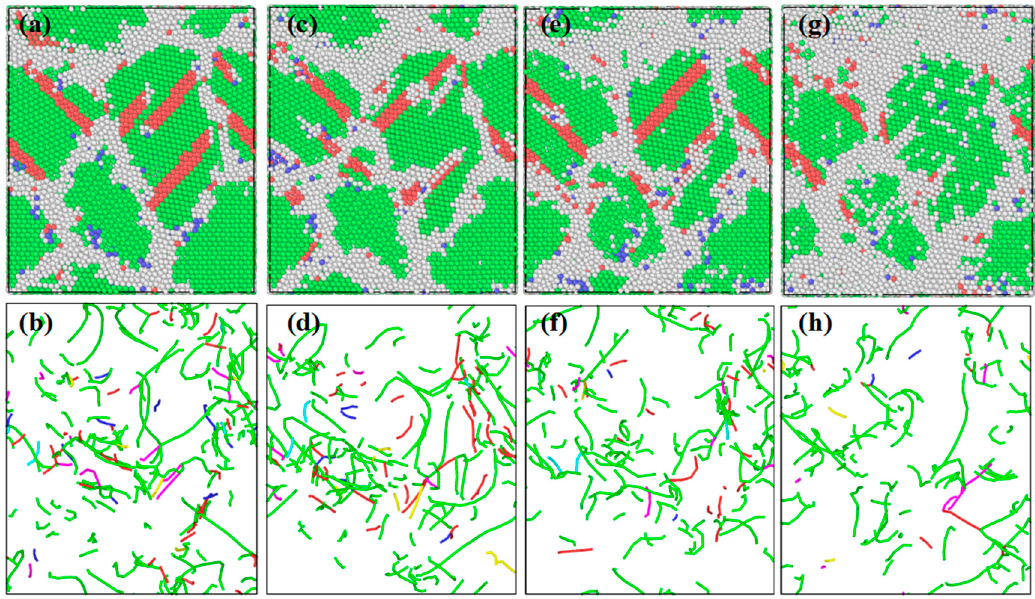
Figure 9. Structure and dislocations of CoCrNi polycrystals at 10% strain at 77 K ( a,b ), 300 K ( c , d ), 500 K ( e , f ), and 800 K ( g , h ).